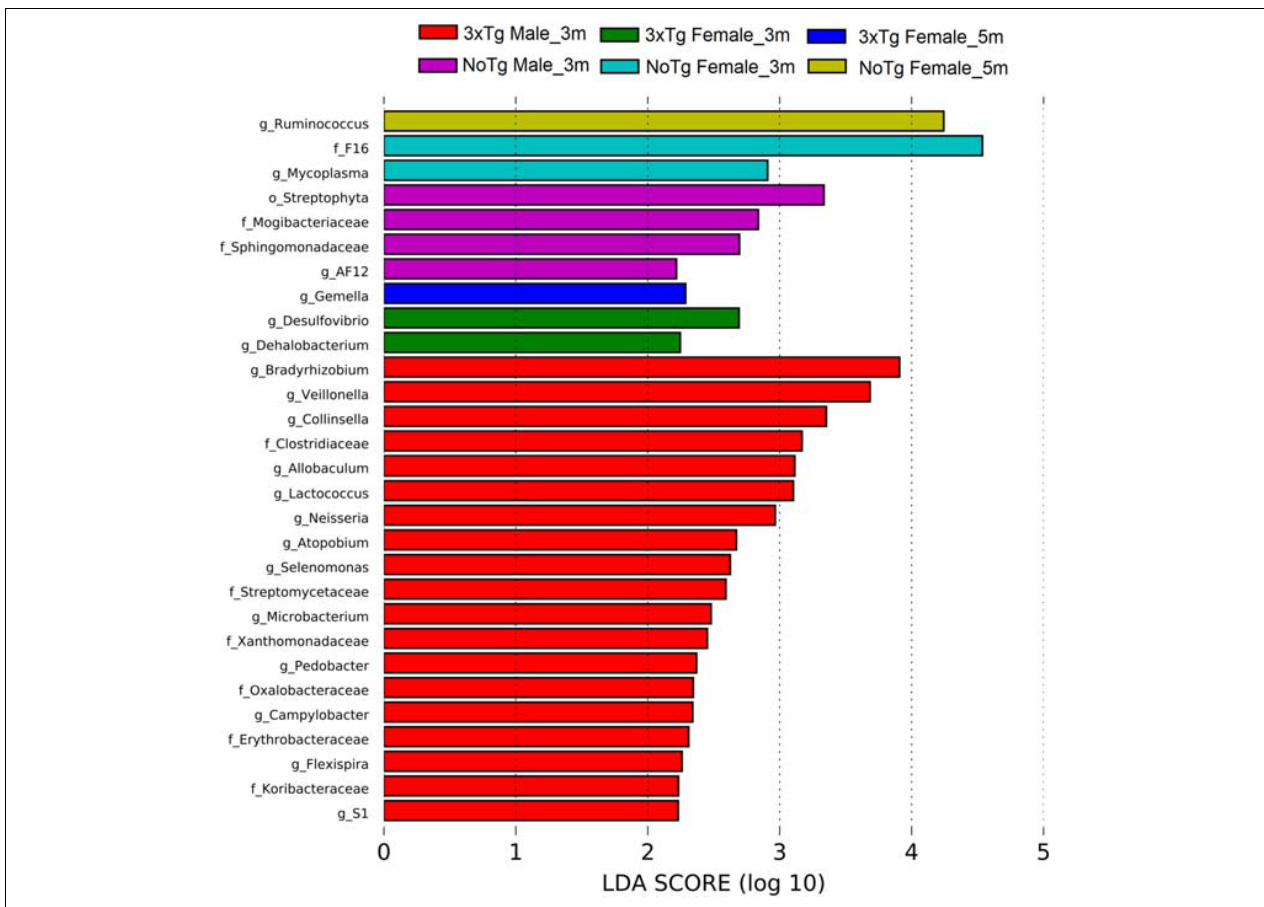
FIGURE 11 | Bacteria with a statistically significant change between non-transgenic (NoTg) and Alzheimer’s disease triple-transgenic (3xTg-AD) mice at 3 and 5 months (m) old in male and female in fecal samples. The bacteria with statistical relevance are shown by colors: red color indicates 3xTg-AD male at 3 months old; green, 3xTg-AD female at 3 months old; blue, 3xTg-AD female at 5 months old; pink, NoTg male at 3 months old; cyan, NoTg female at 3 months old; light olive, NoTg female at 5 months old. Horizontal bars represent the effect size for each taxon. The length of the bars represents the log 10 transformed linear discriminant analysis (LDA) score, indicated by vertical dotted lines. The threshold on the logarithmic LDA score for discriminative features was set to 2.0. The name of bacteria with a statistically significant change in the relative abundance is written alongside the horizontal lines. Taxa names are abbreviated as “o,” order; “f,” family, and “g,” genus. See Supplementary Table 5 for full taxon description and LDA score and p